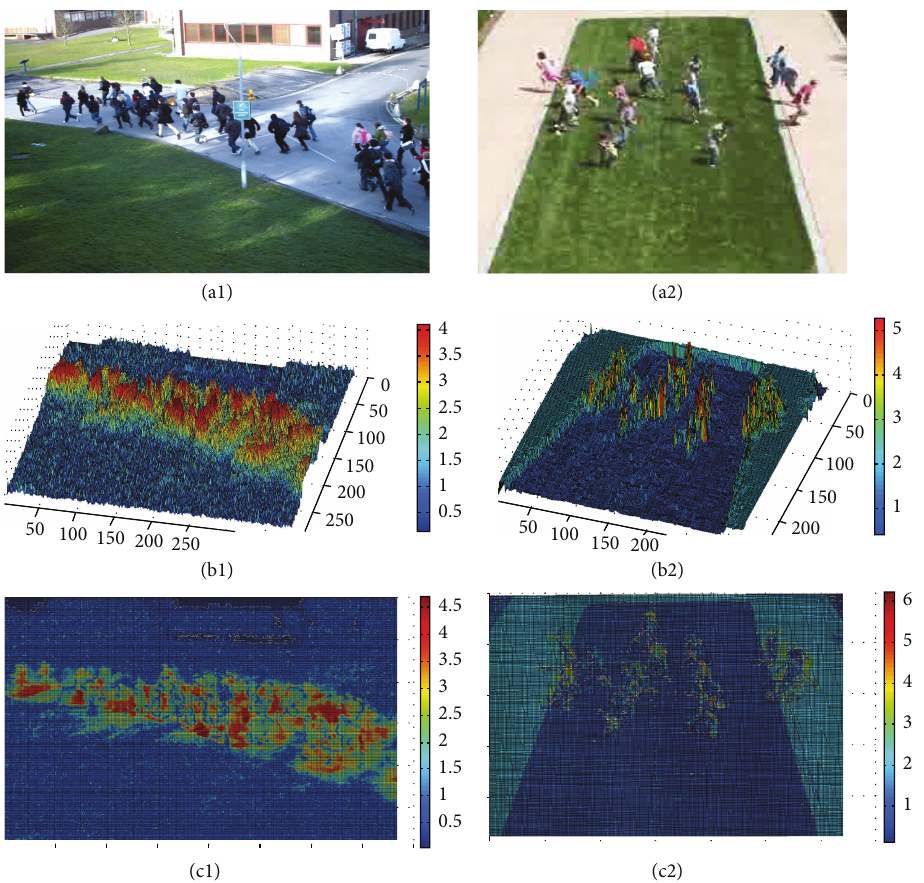
Figure 6: Results of spatiotemporal Weber variation feature. (a1) and (a2) are the original images in the sequences. (b1) and (b2) are the corresponding results of the spatiotemporal Weber variation feature. (c1) and (c2) are the top view of spatiotemporal Weber variation feature